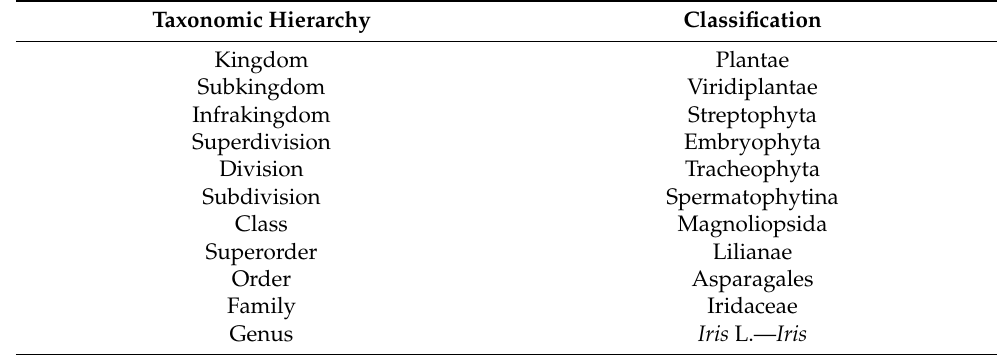
Table 1. Taxonomy of the genus Iris [23]. Taxonomic Hierarchy